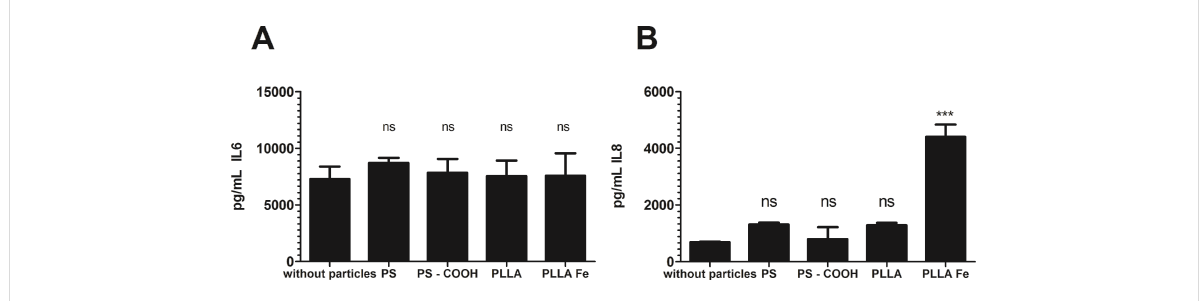
Figure 4: Cytokine secretion of hMSCs treated with different nanoparticles: (A) IL-6, (B) IL-8. hMSCs were incubated with 300 µg/mL particles for 24 h, cytokine detection was performed after 5 days of cultivation with a HTRF assay by analyzing the cell culture supernatant. p > 0.05 ns, p < 0.001 ***.